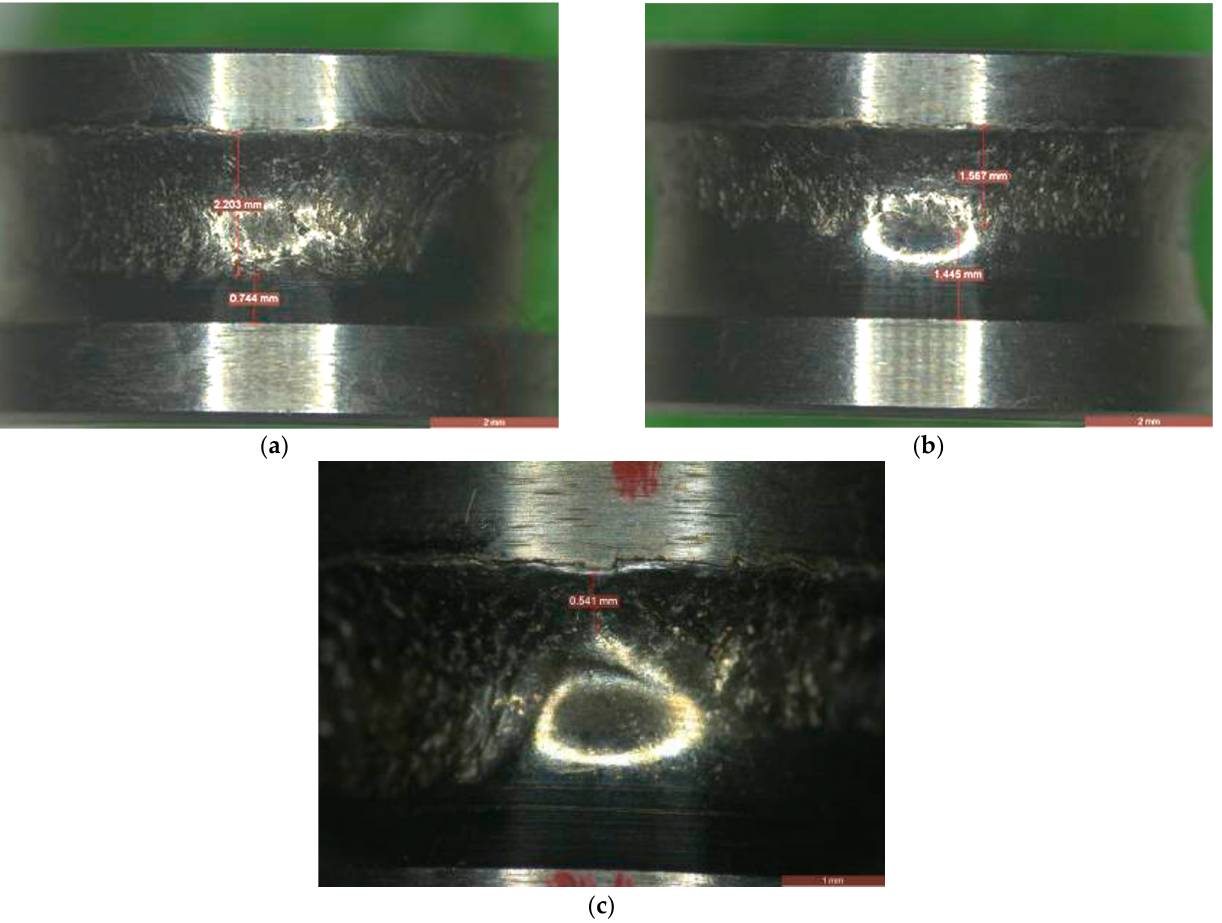
Figure 3. Macroscopic damage of the inner ring raceway: ( a ) severely damaged area; ( b ) lightly damaged area; ( c ) least damaged area.